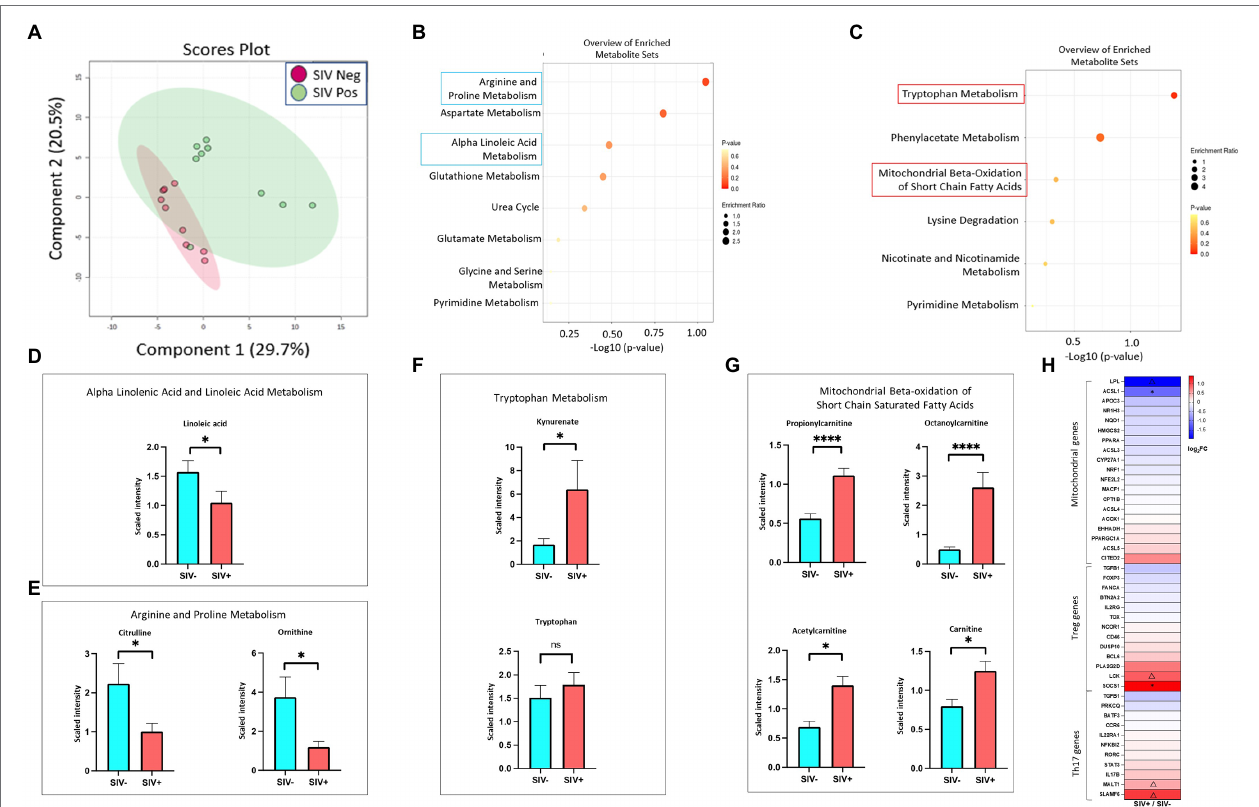
FIGURE 5 | Metabolic changes in the gut reflect persistent ACE2 expression, mitochondrial dysfunction and impaired immune response in SIV infection. (A) PLS-DA plots showing separation between groups (SIV-, n = 8; SIV+, n = 10, 7–10 weeks post infection). Altered metabolites in SIV+ intestinal compartment compared with SIV- controls demonstrated the top 25 downregulated (B) and upregulated (C) metabolic pathways. Fold changes of linoleic acid (D) , citrulline, and ornithine (E) within ileum lumen. Fold changes of significantly altered metabolites in the tryptophan metabolism (F) and mitochondrial beta-oxidation of short chain fatty acids (G) . (H) Heatmap displays differential expression of genes associated with mitochondrial function, Treg and Th17 regulations. Δ p < 0.1, * p < 0.05, **** p <